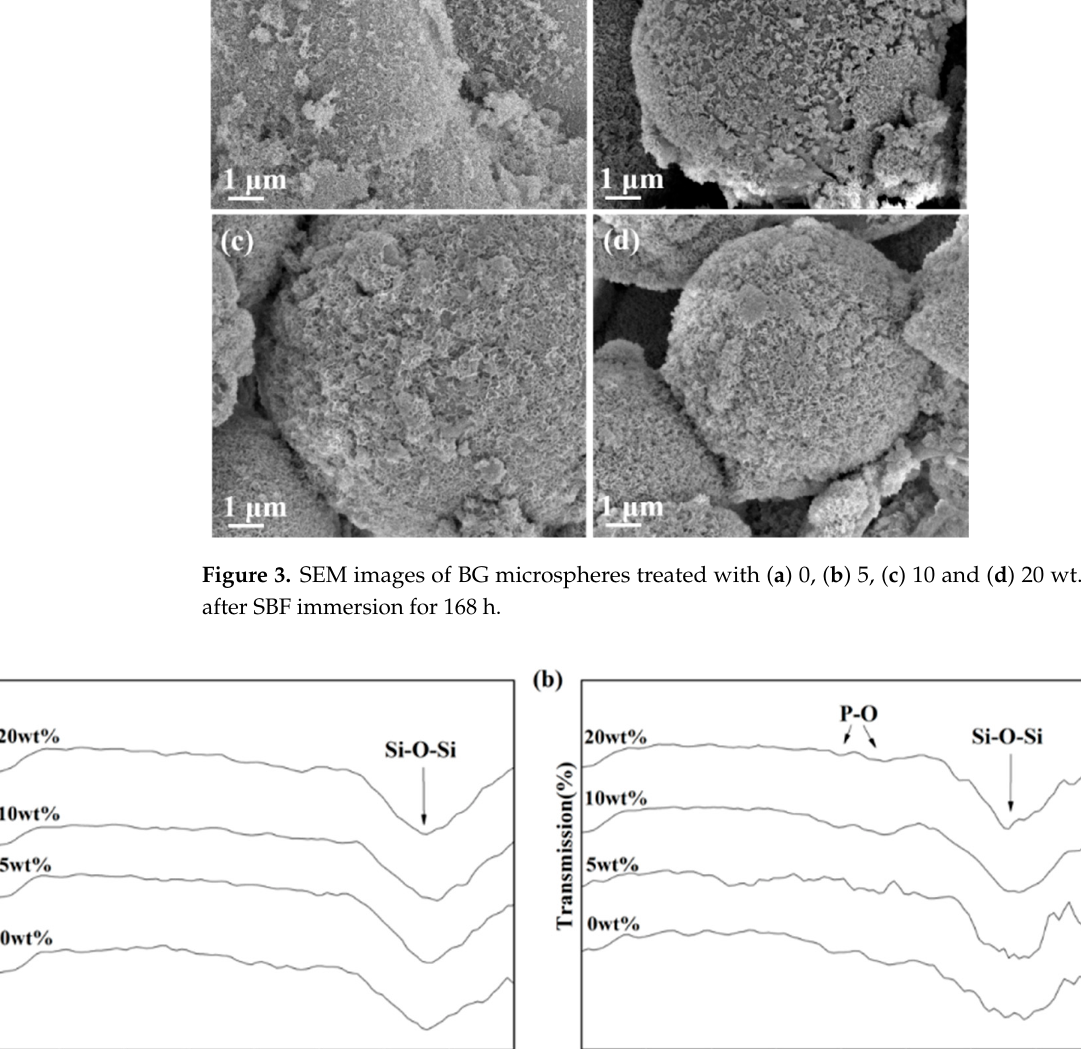
Figure 4. FTIR spectra of BG microspheres treated with 0, 5, 10 and 20 wt.% PMMA ( a ) before and ( b ) after SBF immersion for 168 h.